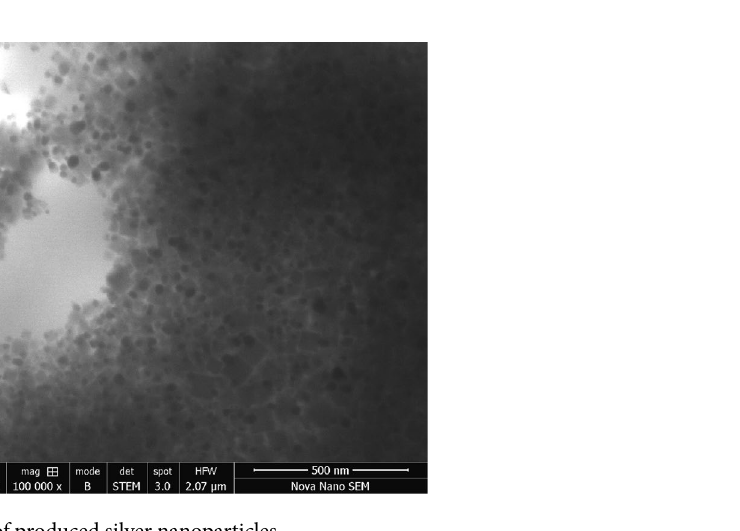
Figure 6. SEM image of produced silver